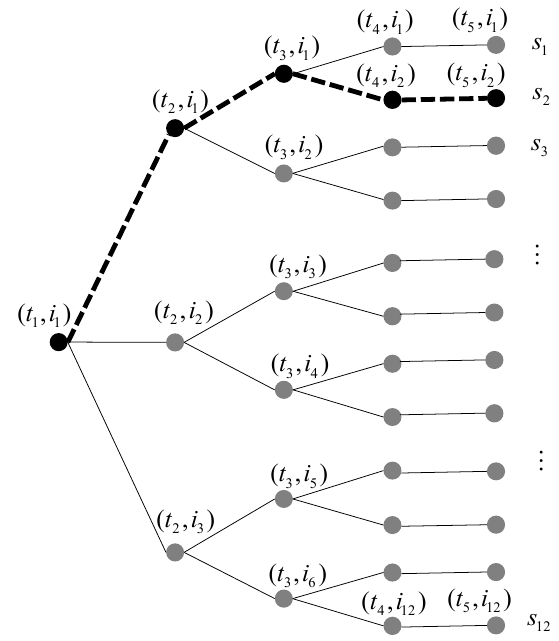
Figure 1. Example of stochastic tree representation used to model the uncertainty.